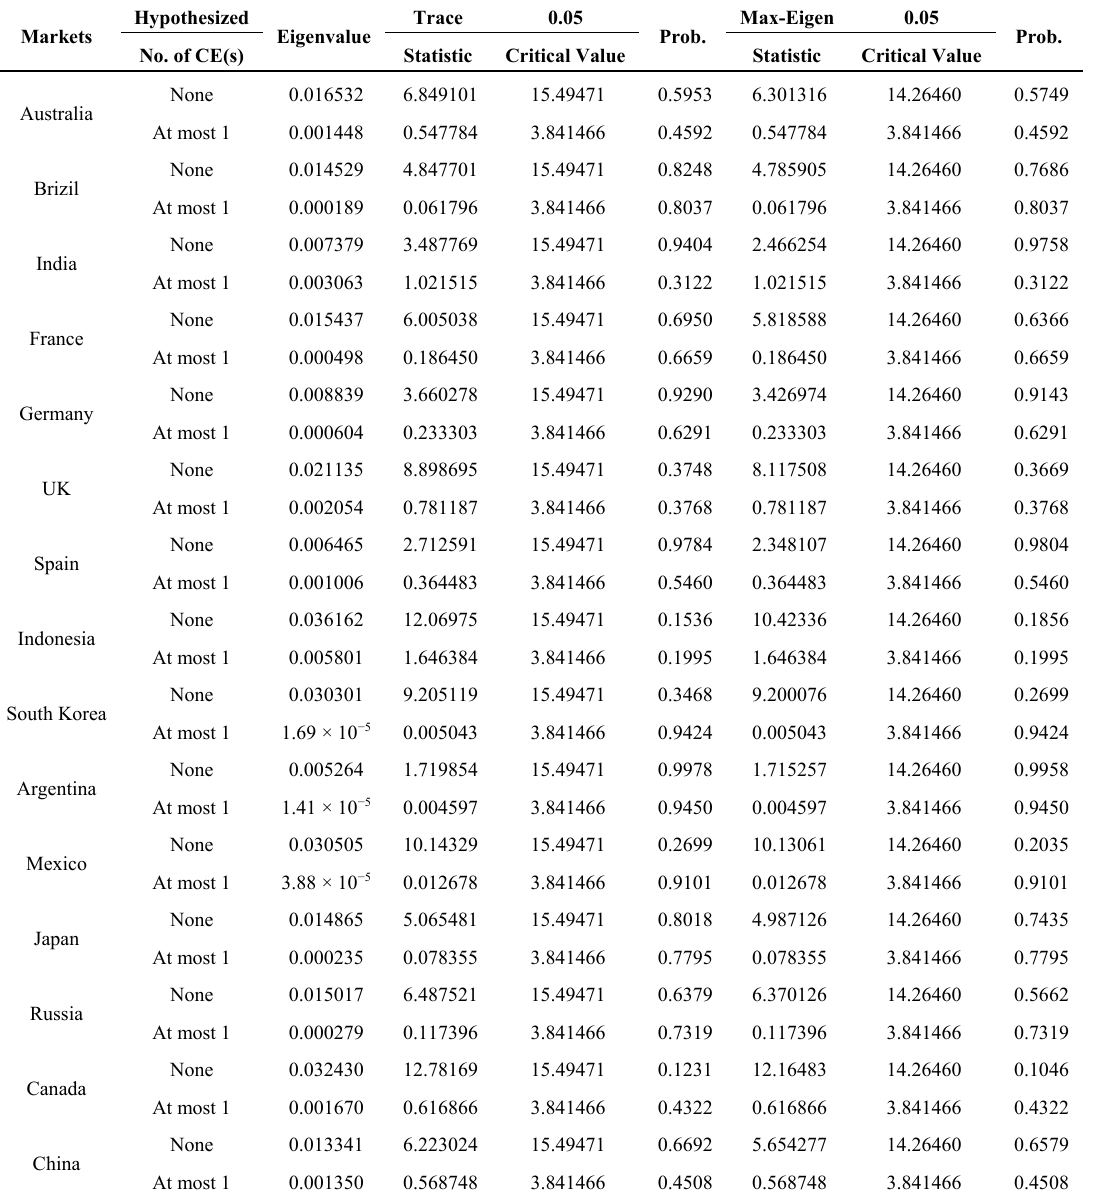
Table A8. Test for Johansen Cointegration in Sub-period